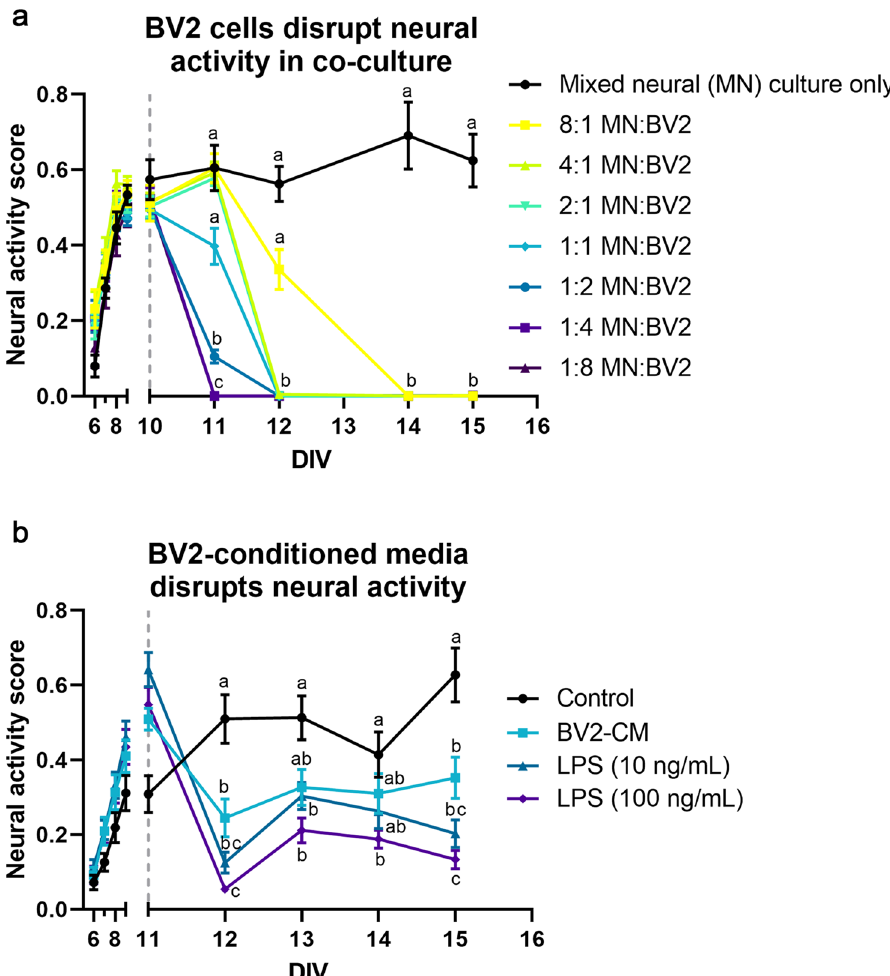
Figure 4. Disruption of neural network ontogeny is easily quantified using neural activity score. ( a ) Co-culturing mixed neural cultures and microglia (BV2 cells) results in a microglia concentration-dependent disruption of neural activity (p < 0.0001, two-way repeated measures ANOVA, Tukey’s post-hoc test, n = 6/ group). ( b ) Similarly, BV2-conditioned media treatment resulted in a similar decrease (p < 0.0193, two-way mixed ANOVA, Tukey’s post-hoc test). Additionally, 24-h LPS treatment of BV2s prior to conditioned media collection exacerbated this disruption in a concentration-dependent manner (10 ng/mL, p = 0.0003; 100 ng/mL, p < 0.0001) (n = 14/group except media control group, for which n = 12). Grey dashed lines indicate time of BV2 or CM addition. Reported statistics are Tukey’s post-hoc comparisons 24 h post-addition. Connecting letters on graphs indicate comparisons for other time